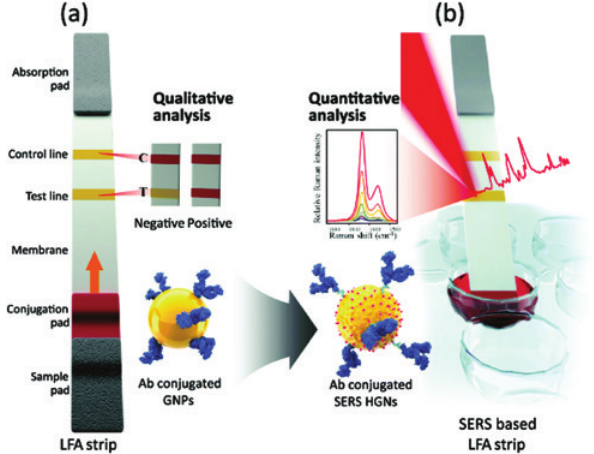
Figure 12: Schematic of a lateral flow based platform for the detec- tion of analytes from whole blood using paper